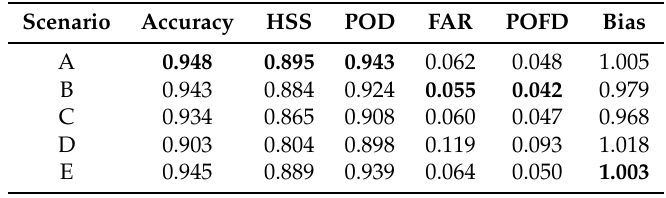
( c ) Metrics for the cloud-filled